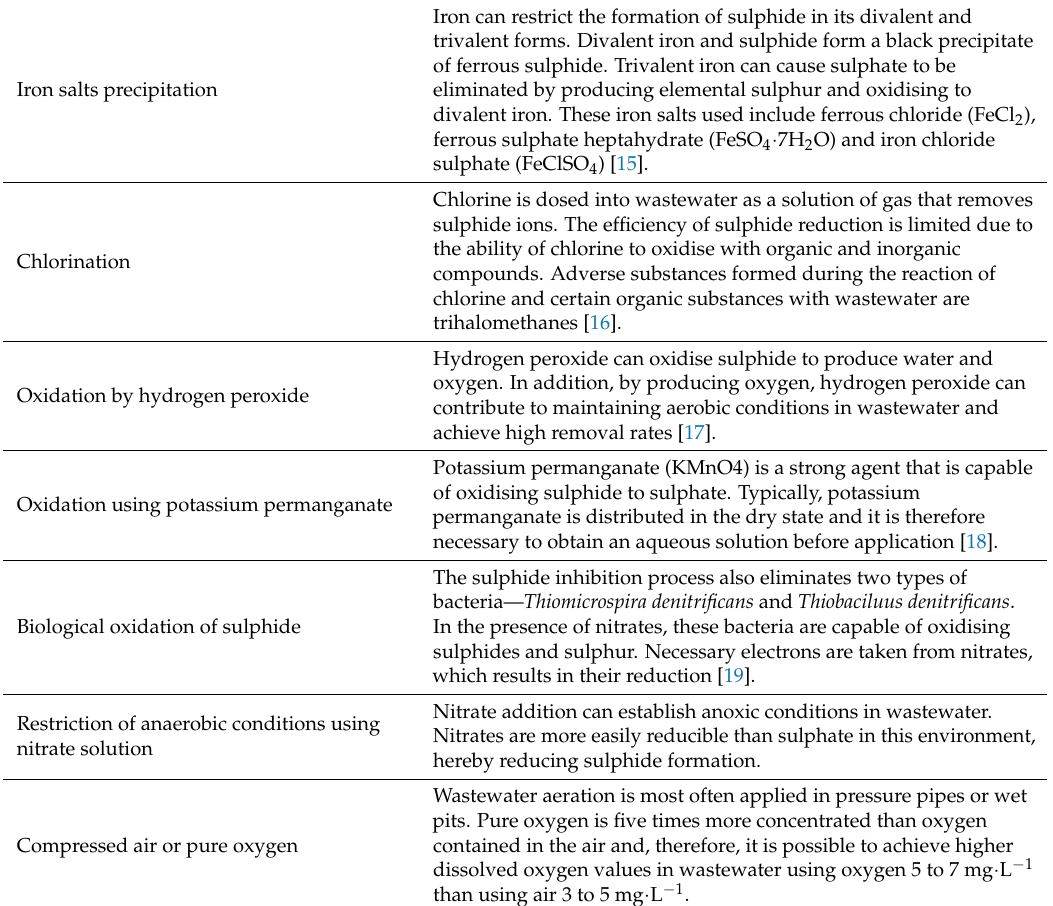
Table 1. Methods of removing odour from